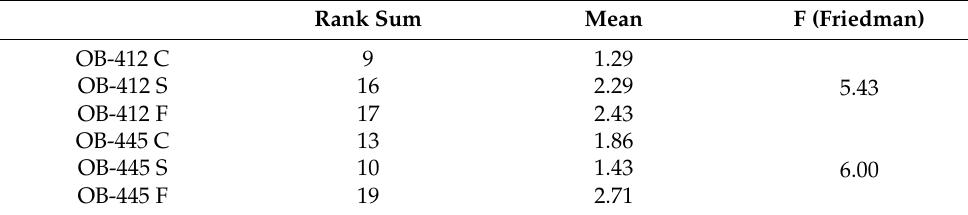
Table 3. Ranking test